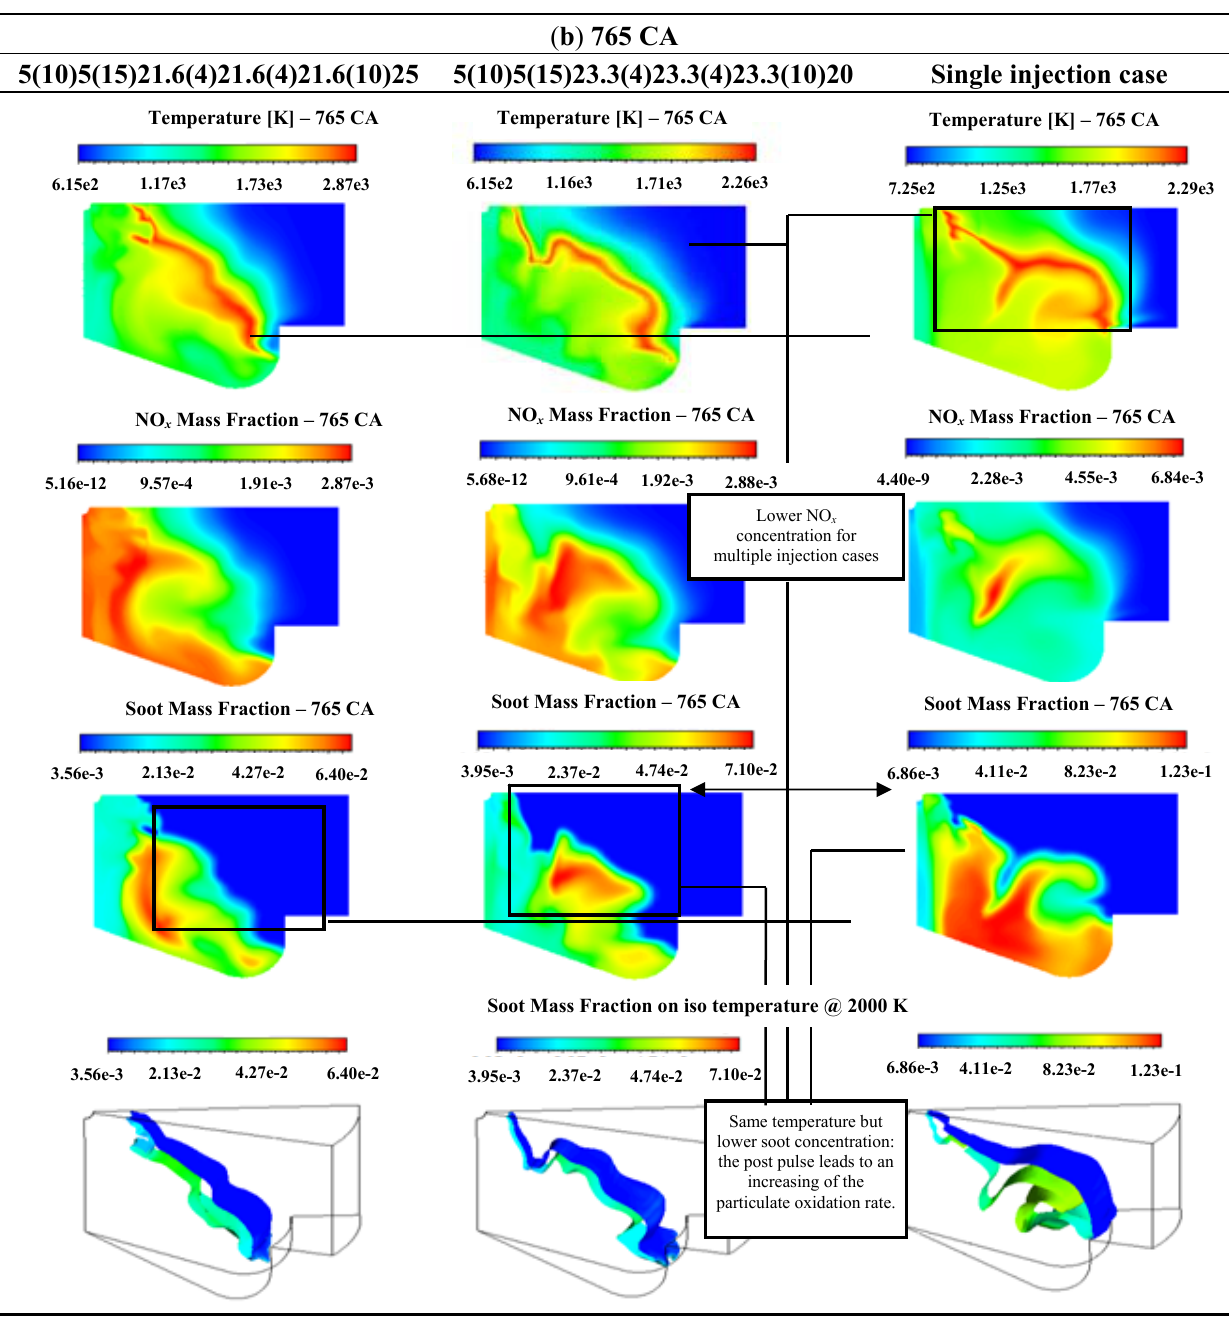
Figure 15 . Cont. ( b ) 765 CA